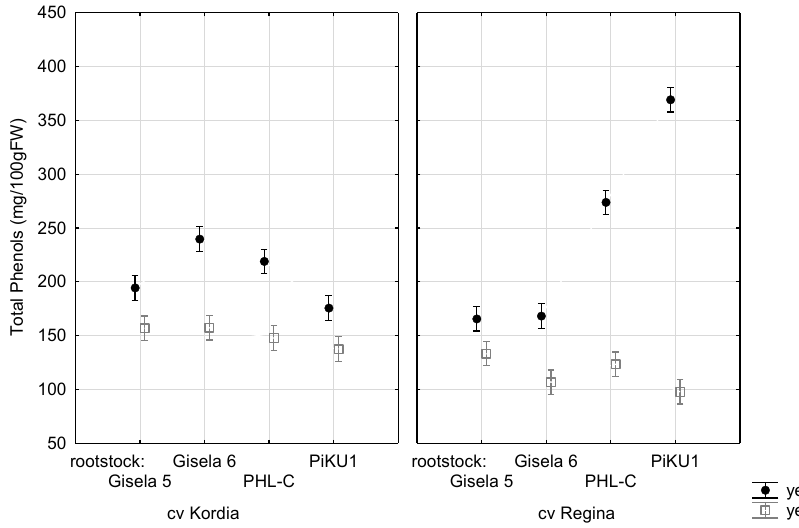
Fig. 1: Total phenol content (mg/100 g FW) of cvs. ‘Kordia’ and ‘Regina’ grafted on 4 different rootstocks during 2013 and